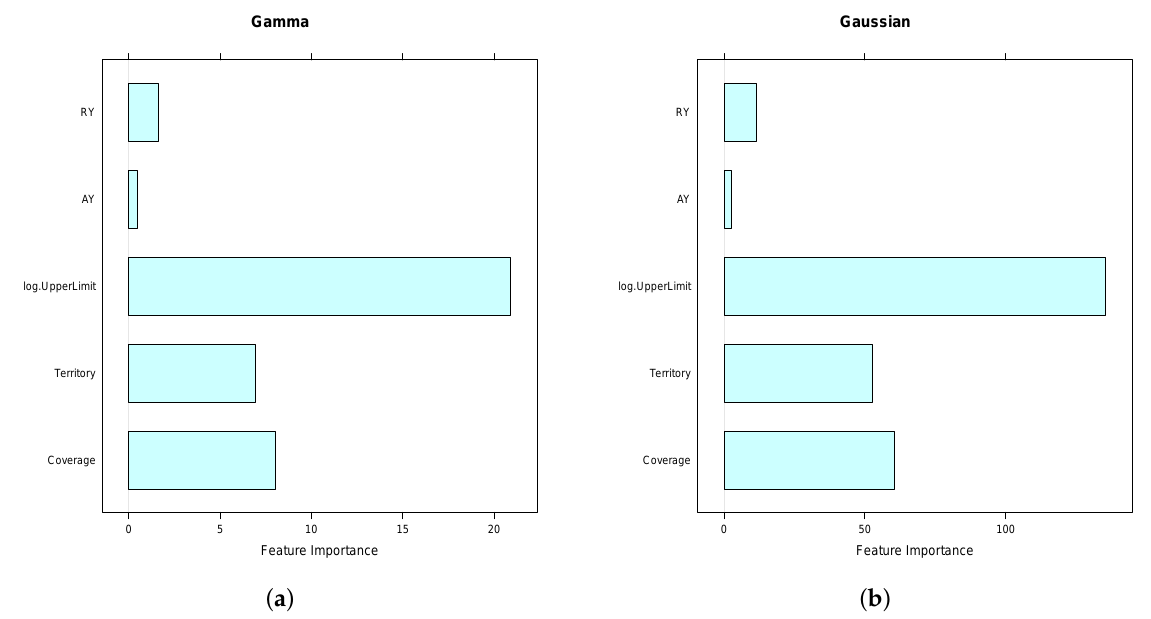
Figure 6. Bar plots for variable importance measures of risk factors in GAM based on the log scale claim amount. ( a ) Gamma as an error function in GAM. ( b ) Gaussian as an error function in GAM.